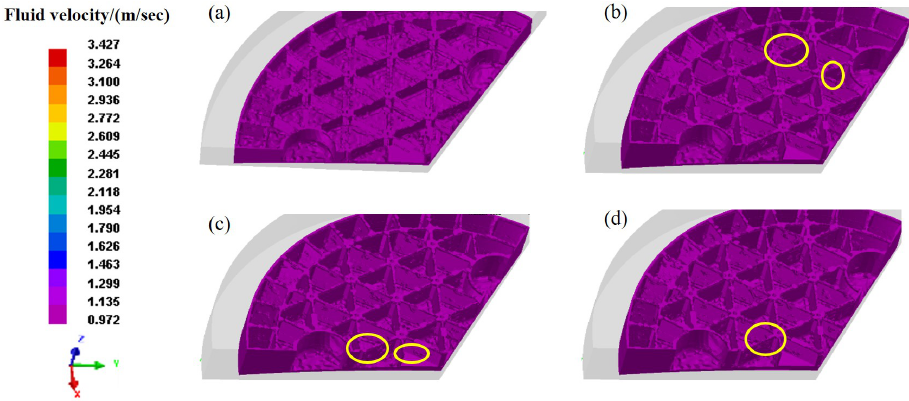
Figure 9. Fluid velocity of green body at different pressing speeds. ( a ) 20 mm/s; ( b ) 10 mm/s; ( c ) 5 mm/s; ( d ) 1